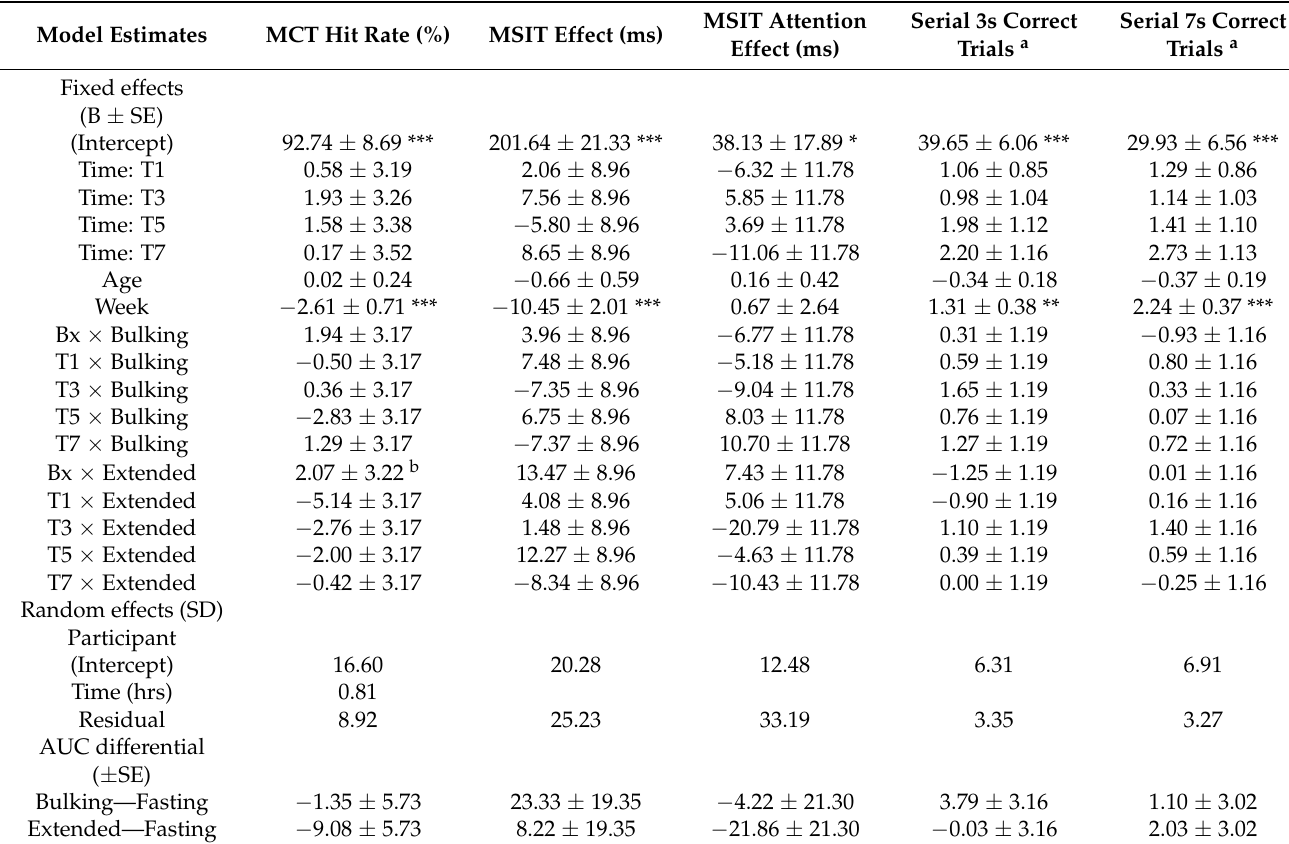
Table 6. Linear mixed effect model estimates and AUC differentials for cognitive fatigue battery